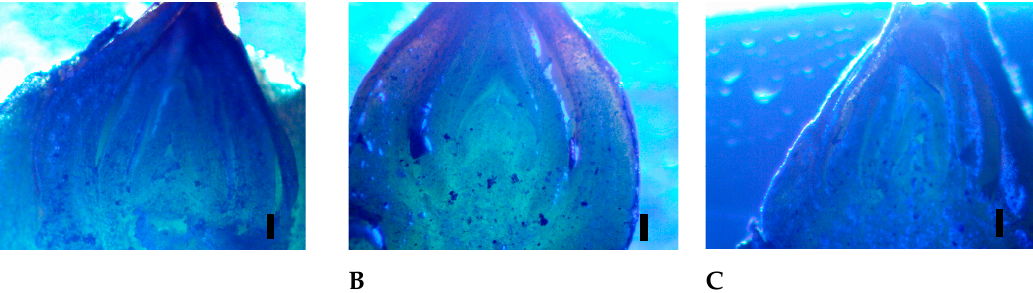
Figure 8. A cross section of a bud in summer ( A ), leaf fall ( B ), and full endodormancy ( C ) in ‘Haku-Botan’. The bar represents 200 µm.